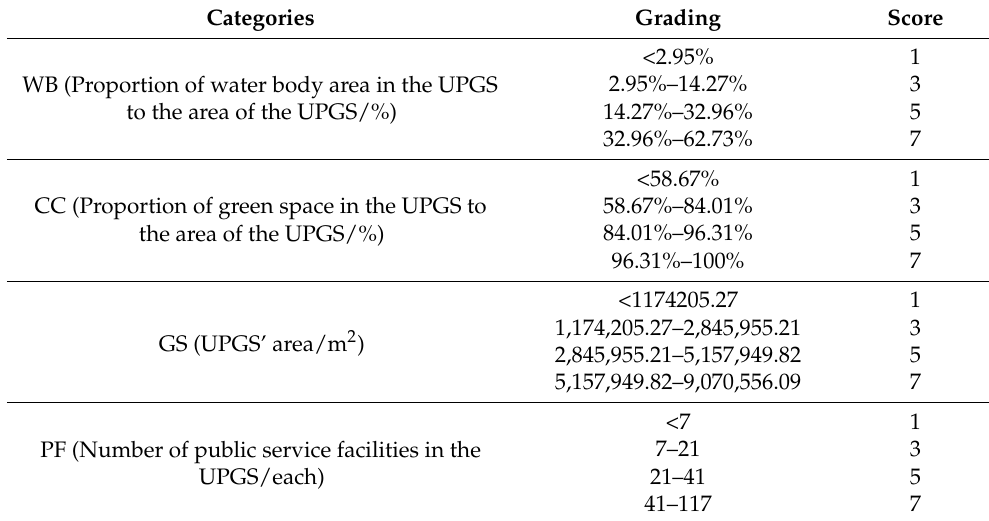
Table 2. The grading status of UPGS quality